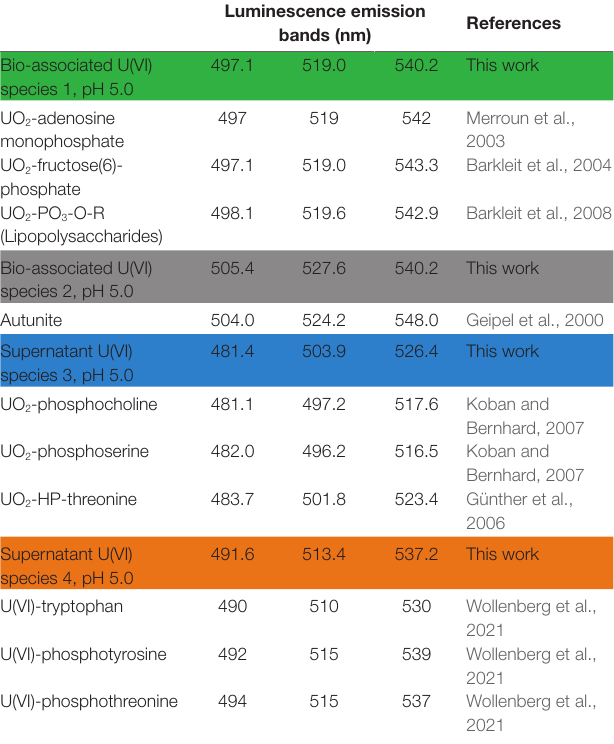
TABLE 1 | Luminescence emission bands of the two determined U(VI) species of Penicillium simplicissimum KS1 cells exposed to 0.1 mM U(VI) compared to band positions of reference spectra of organic uranyl phosphate